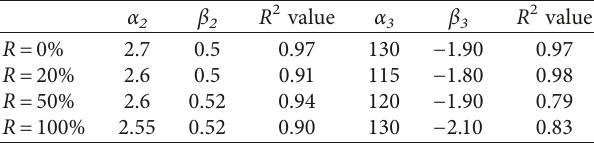
Table 2: Coefficients of (22) and (23) for relative density and concrete compressive strength estimation at 28 days in